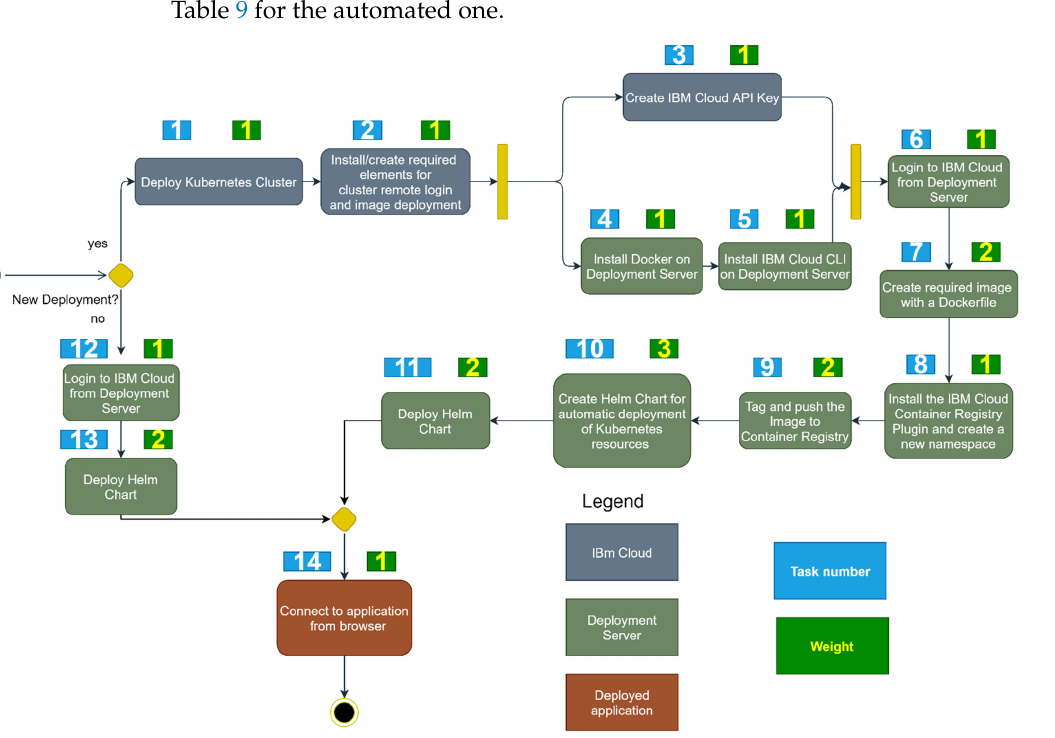
Figure 4. The weighted automated deployment process.